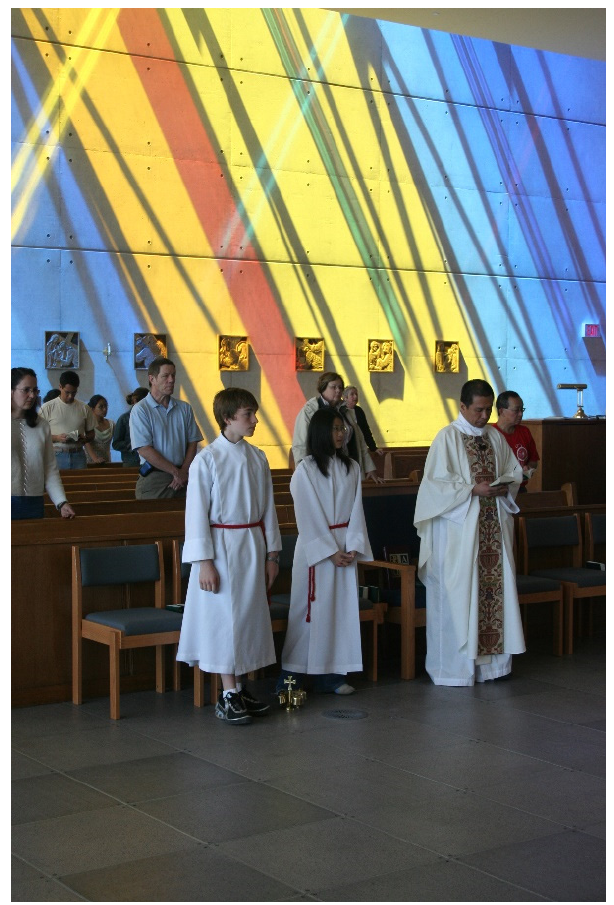
Figure 7. View of the worship space west wall at the beginning of the 12:30 p.m. mass (Credit: Roberto Chiotti).